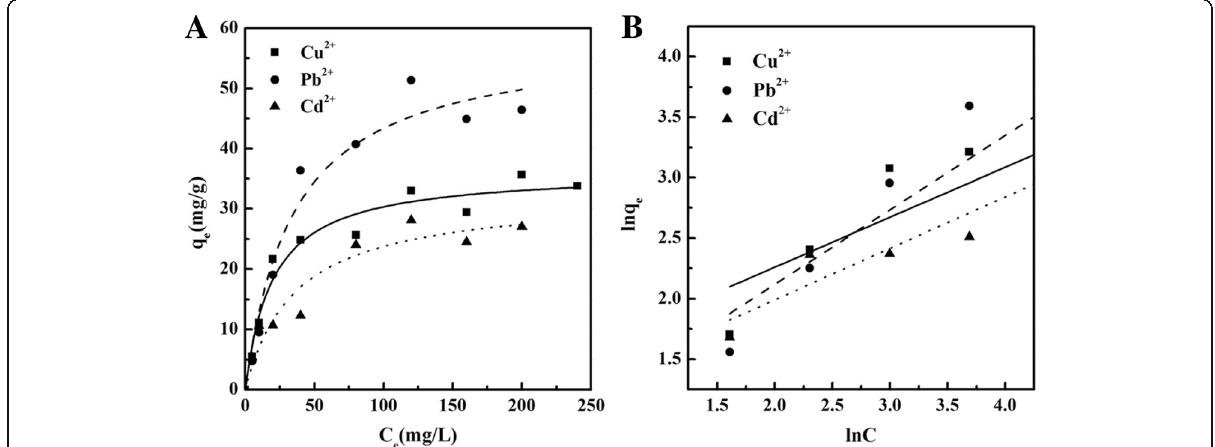
Fig. 6 Adsorption isotherms of Cu 2+ , Pb 2+ , and Cd 2+ on c-MCM-41(40). A Langmuir. B